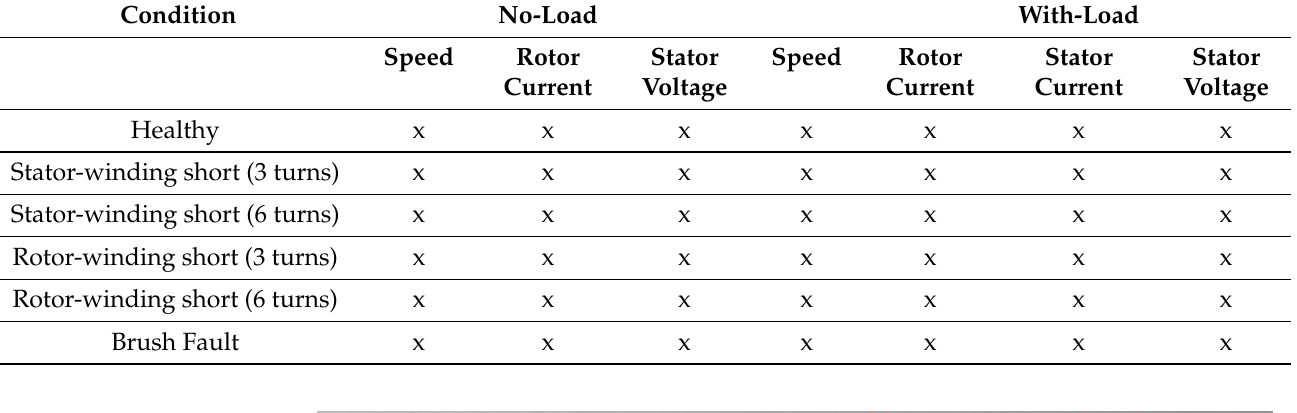
Table 2. Parameters recorded under different conditions during no-load and load operation.